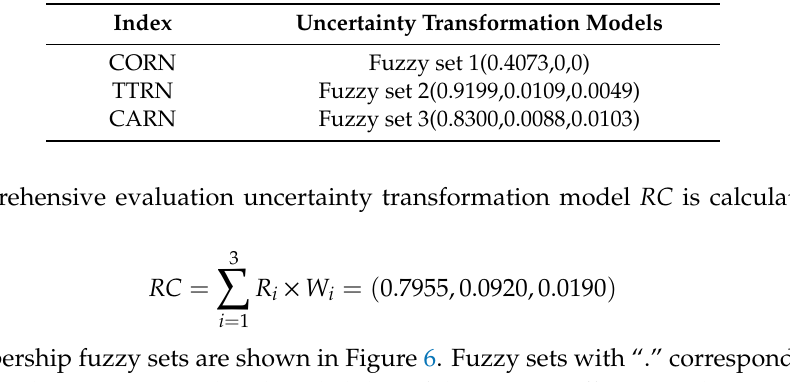
Table 9. Uncertainty transformation models of the CORN, TTRN, and CARN.